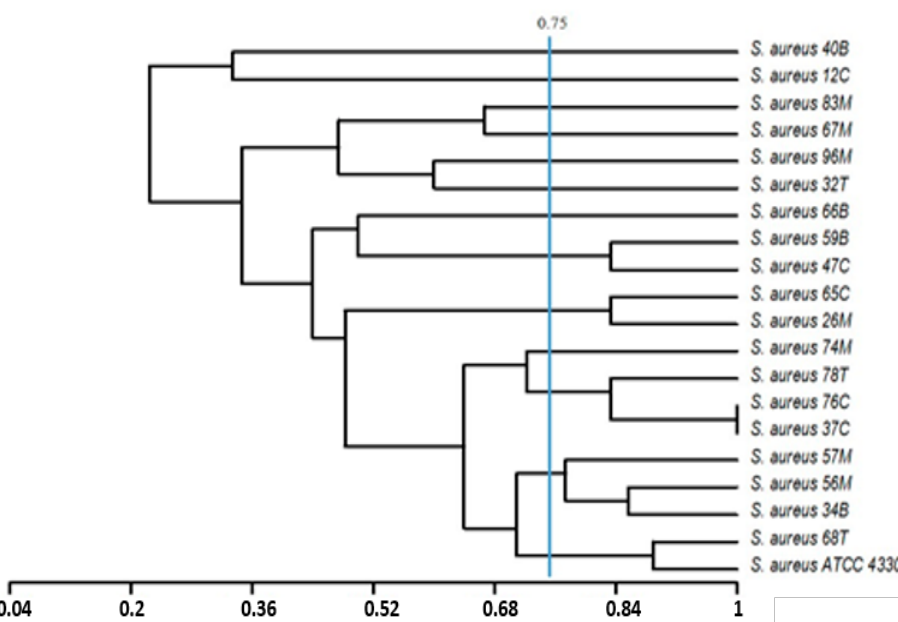
Figure 4. Dendrogram based on the unweighted pair group method of arithmetic averages and Jaccard’s correlation coefficient on the basis of the genetic traits of the S. aureus population (distribution of some virulence-related genes: mec A; ssp A, ssp B; geh ; hla ; ica A, ica D, cna , fnb A). Numbers on the horizontal axis indicate the percentage of similarity.